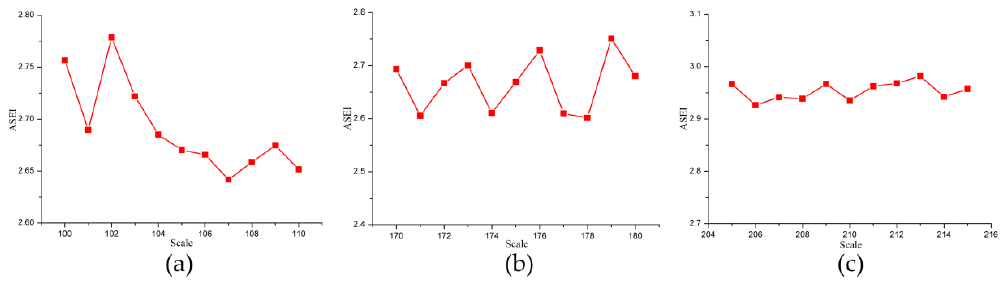
Figure 9. Line chart of the ASEI index for DS1 at scale ranges of ( a ) 100 to 110, ( b ) 170 to 180, and ( c ) 205 to 215.